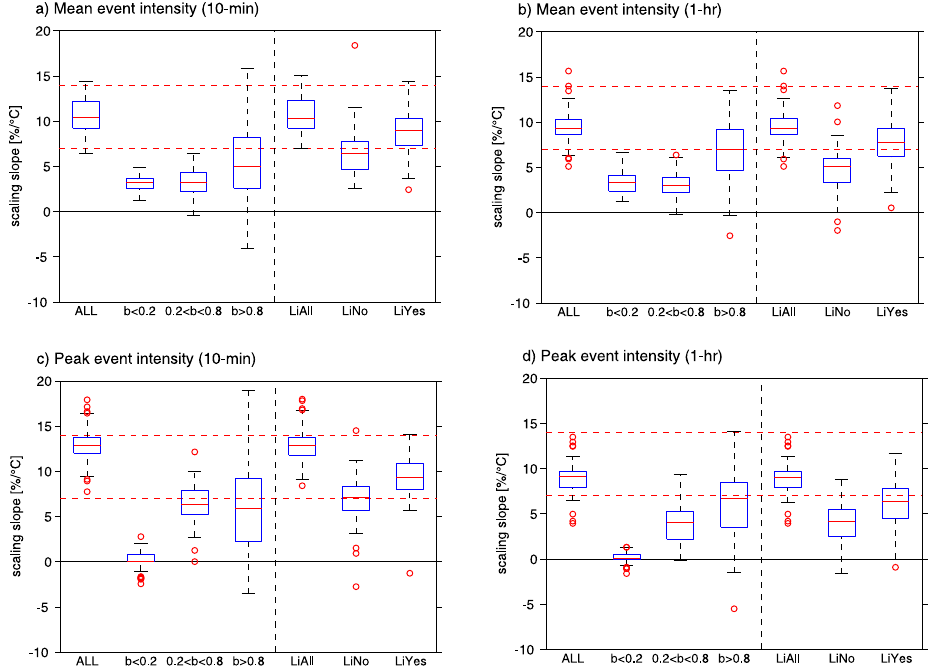
Figure 6. Box plots showing the distributions of scaling slope magnitude for mean event intensity I m at the (a) 10min scale and (b) 1h scale, and for peak event intensity I p at the (c) 10min scale and (d) 1h scale. The slopes were estimated using the quantile regression method for the 95th percentile. The data are organised into different subgroups (from left) using all events (1981–2011, ALL), three convectivity levels, all events with lightning data (1987–2011, LiAll), and the division into no-lightning (LiNo) and lightning (LiYes) subsets. The red line shows the median; the upper and lower bounds are the 25th and 75th percentiles (25P and 75P). The whiskers are calculated as 75P ± 1.5(75P–25P). Outliers are plotted as red circles. The horizontal dashed line shows the CC rate (7% ◦ C − 1 ) and 2CC rate (14% ◦ C − 1 ). The same figure for the temperature binning method is in the